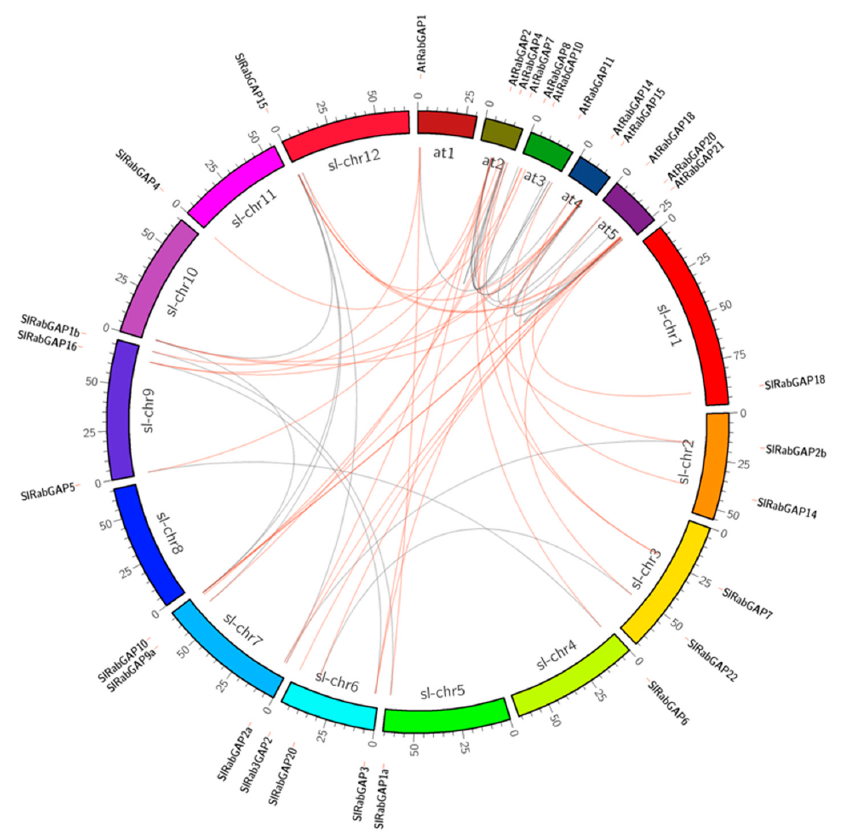
Figure 2. Syntenic relationships among RabGAP. Paralogy and orthology relations between RabGAP from S. lycopersicum and Arabidopsis thaliana . Orthologous and paralogous genes are connected by red and gray lines, respectively. Table 2. Evolutionary parameters for duplicated RabGAP genes. Table shows Ka / Ks ratios, duplication and selection types and time of divergence. Gene Pairs